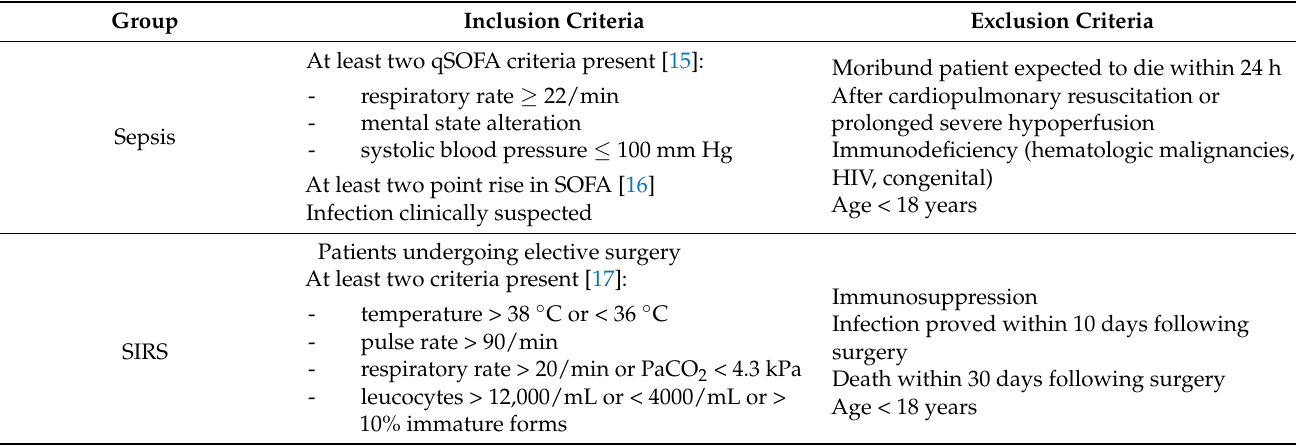
Table 1. Inclusion and exclusion criteria for the Sepsis and SIRS Groups.